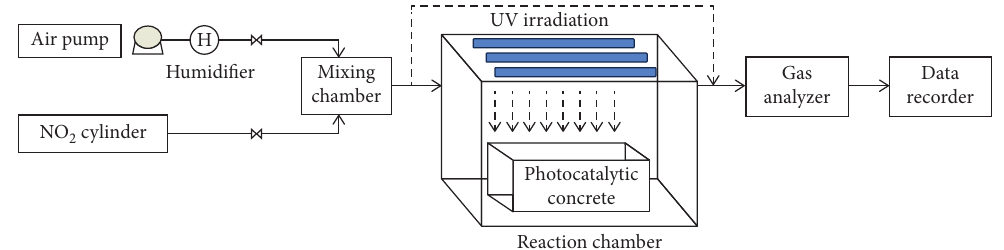
Figure 3: Sketch of the laboratory setup.